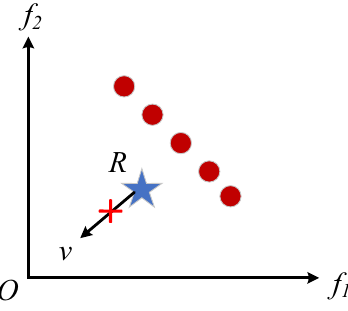
Fig. 2 Parts of non-dominated solutions dominates the reference point